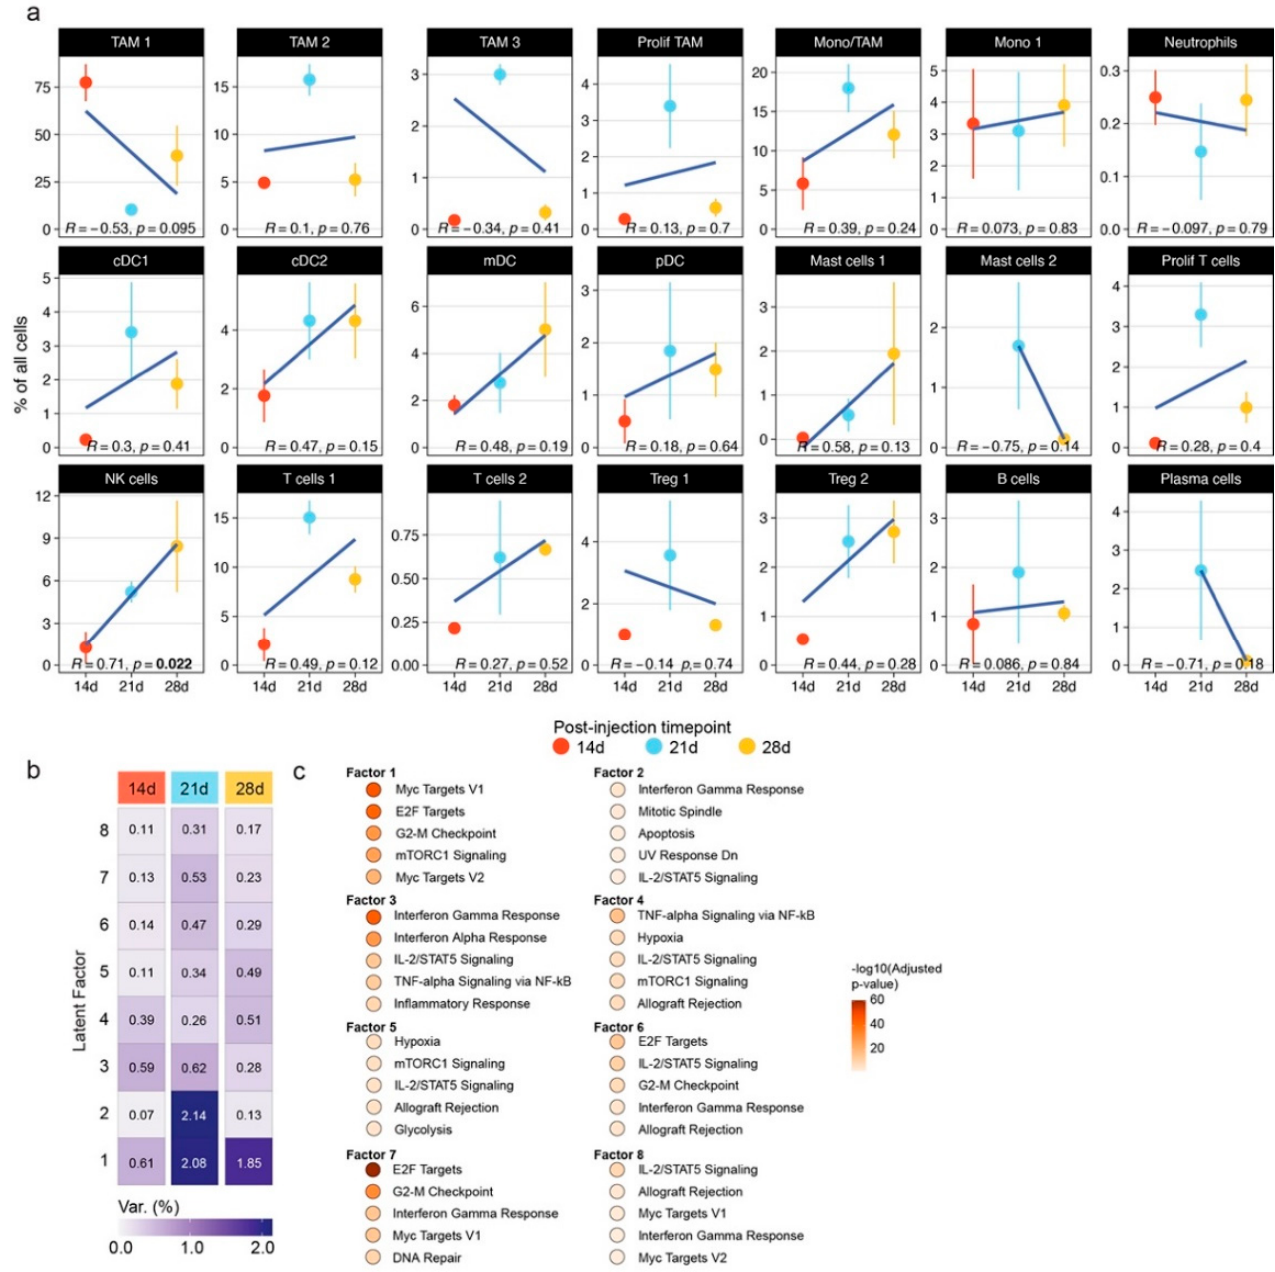
Figure 2. Cell type dynamics during GL261 murine orthotopic glioma progression and transcriptional changes in NK cells. ( a ) Dot line plot visualization of the relative abundances of the indicated cell types as a percent of the total number of immune cells for each time point. The error bar indicates the s.e.m. The cell labels are adapted from the 21 d p.i. time point dataset [20]. At the bottom of each plot, the Pearson’s correlation coefficient and two-sided p -value are indicated. ( b ) Heatmap visualization of latent factors determined by MOFA+ analysis. The color scale indicates the percentage of variance explained. For enhanced readability, the respective values are indicated in each cell. ( c ) The enrichR-based pathway enrichment analysis of MSigDB Hallmark 2020 pathways. The color of the dots indicates the -log10-transformed adjusted p -values of the enrichment.